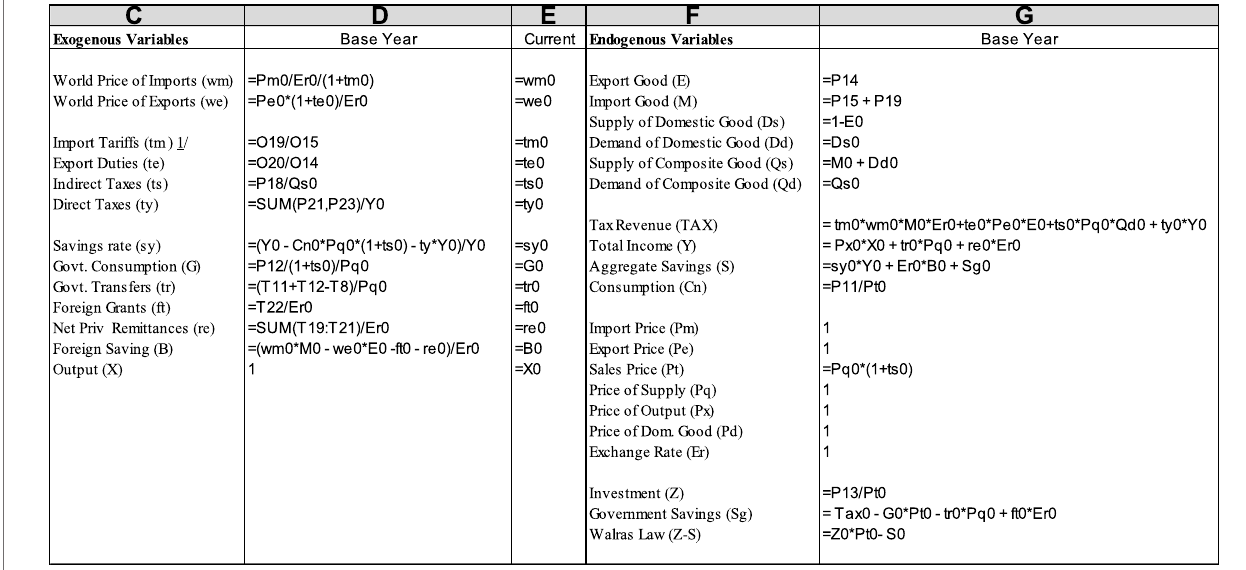
FIGURE 2 | Variable calibration of the “ 1-2-3 ” model.